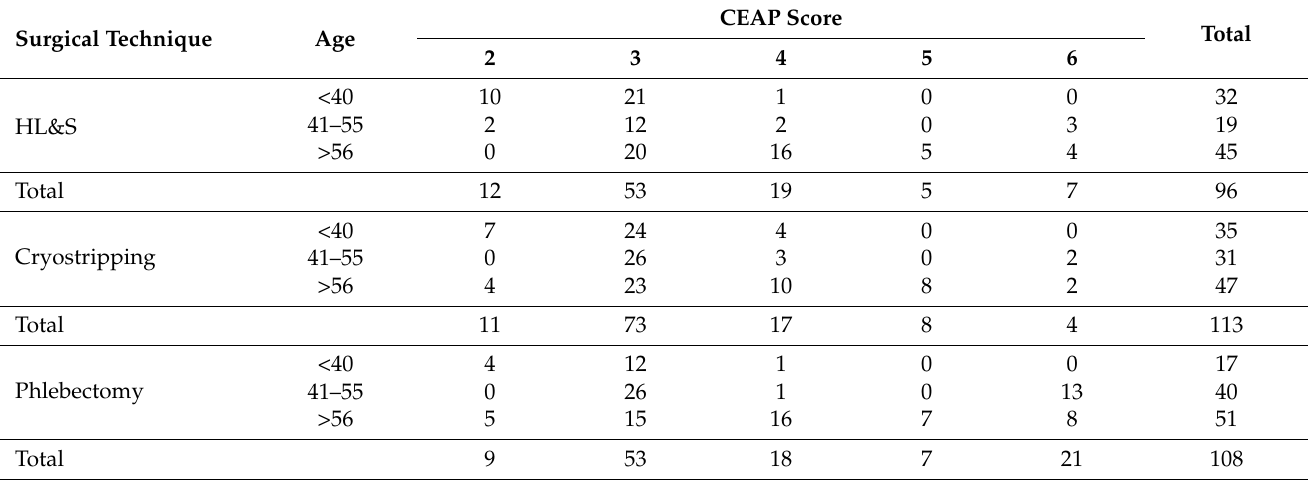
Table 1. Clinical-Etiological-Anatomical-Pathophysiological (CEAP) score according to patients’ age and type of